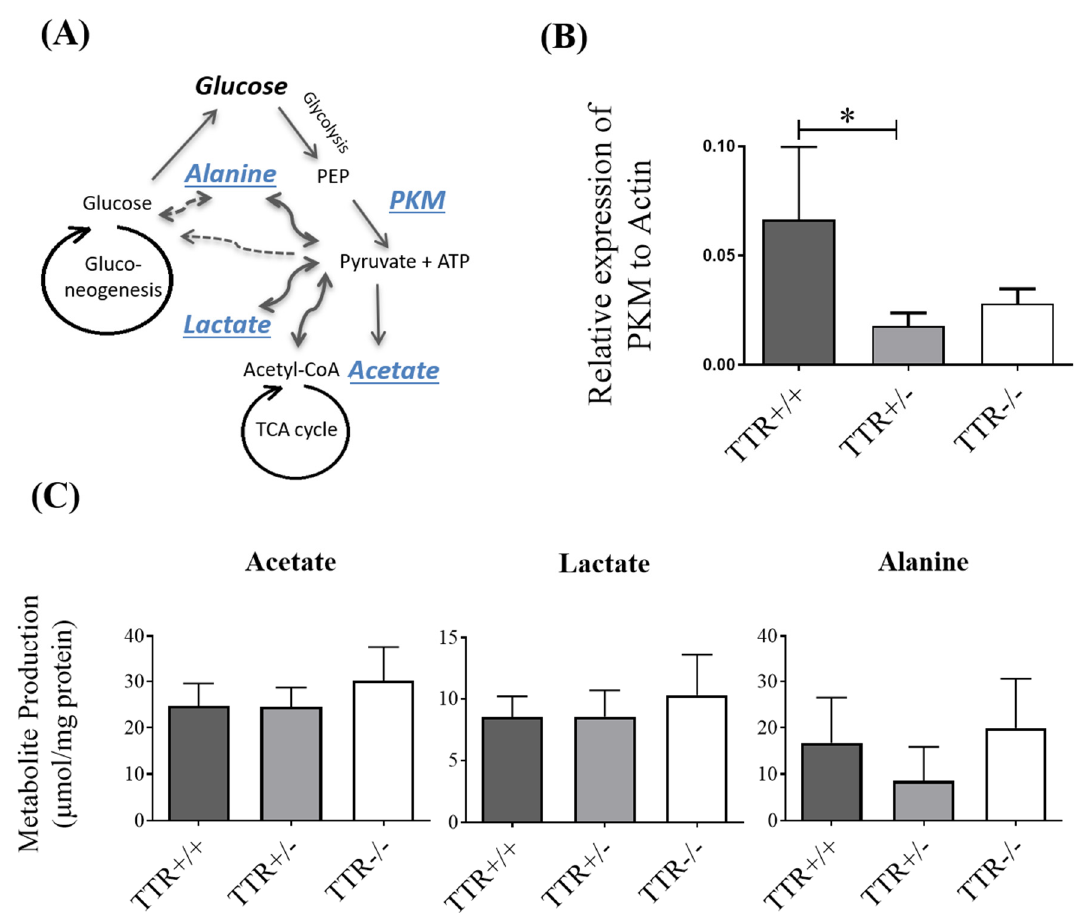
Figure 3. Effect of TTR on the expression of liver PKM enzyme and hepatic production of glucose-derived metabolites. ( A ) A simple schematic representation of the metabolic pathways of glucose: during glycolysis, glucose is converted to pyruvate, through the action of PKM on PEP, producing ATP. Pyruvate can further turn into acetate, lactate, and alanine and/or enter the mitochondrial TCA cycle for further production of energy. Glucose can also be produced through gluconeogenesis in the liver. ( B ) In mouse livers, the relative expression of PKM, assessed by qRT-PCR, was shown to be lower in TTR+/ − livers compared to those from TTR+/+ animals ( N = 4 for each genotype). ( C ) In primary hepatocytes, the production of acetate, lactate, and alanine was assessed by 1 H-NMR spectroscopy. No significant differences were observed in their production by hepatocytes from different TTR backgrounds mice ( N = 6 for each condition). Data are expressed as mean ± SD. Significant results are indicated by * when p < 0.05.